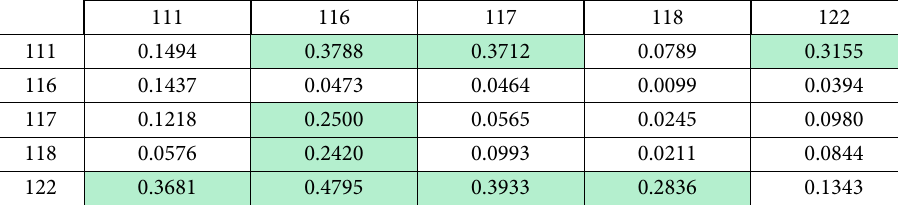
Figure 7. DEMATEL relationships diagram for C5 Table 23. Total influence matrix T